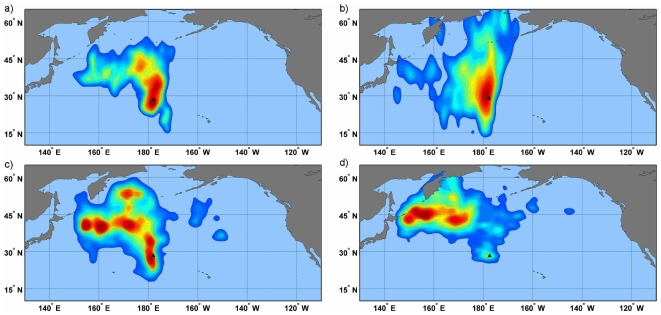
At-sea utilization distribution kernels for Laysan albatross foraging from Kure Atoll.Kernels increase in 2% increments from 2%–95% with increasingly warmer tones represent the highest utilization distribution (2%). Kernels are shown for the a) incubation b) chick guard c) post-guard and d) non-breeding stages. Colony location is indicated by a triangle.